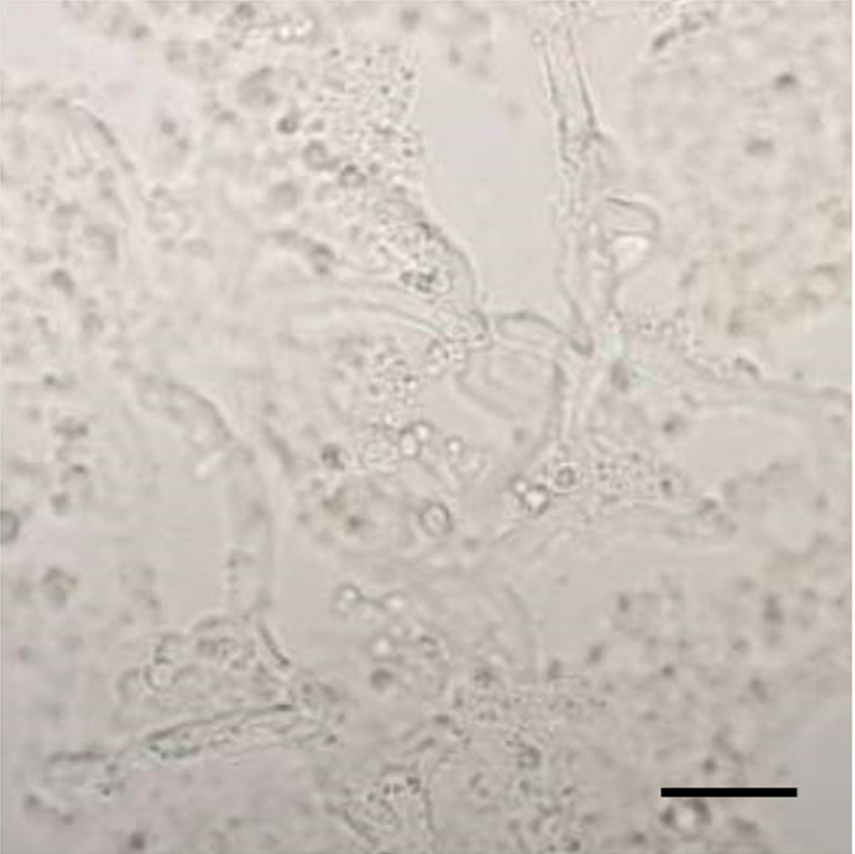
Figure 3. Direct examination of the vascular tissue by using potassium hydroxide preparation showed sparsely septate hyphae (×400; the bar scale is 20